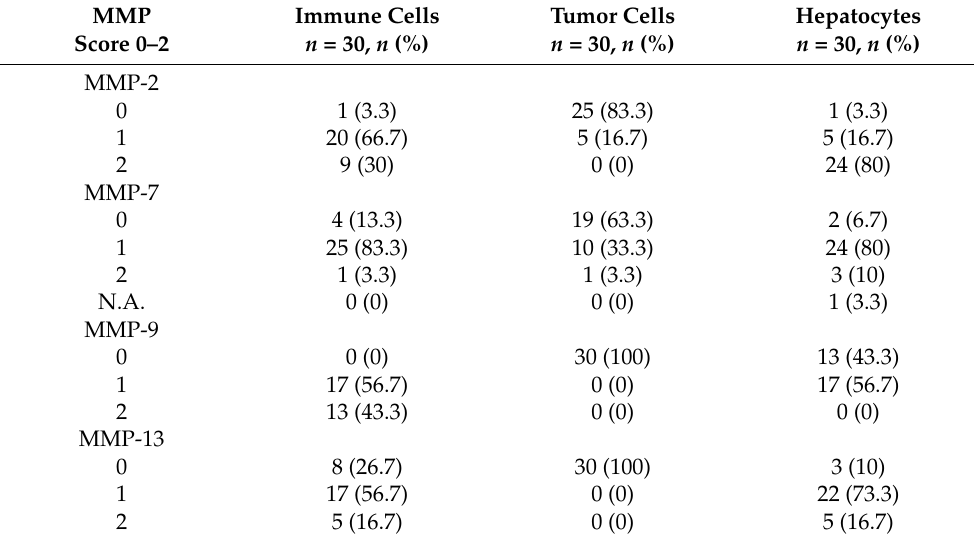
Figure 3. Immunohistochemical staining of matrix metalloproteinases (MMP) (brown) in colorectal liver metastases (CLM) ( n = 30). ( A – D ) The analysis shows that MMP-2, -7, -9, and -13 are mainly expressed in hepatocytes (arrow) and ( E – H ) immune cells (arrow). Magnification ×40. Table 2. Median score of MMP * expression in colorectal liver metastases.